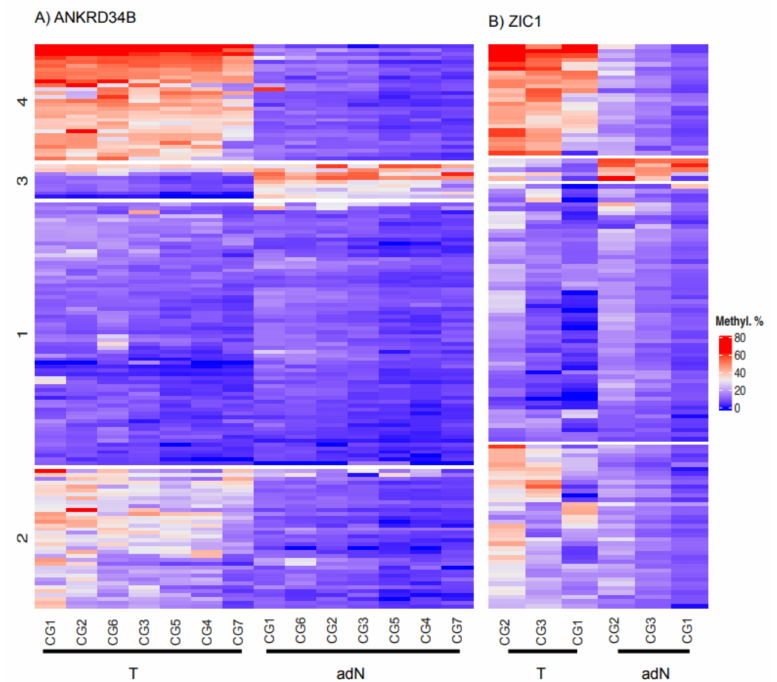
Figure 5. Heatmap presentation of kmeans clustering of CpG site specific methylation in paired tumor adjacent normal and tumoral tissues for independent clustering’s of ANKRD34B ( A ) and ZIC1 ( B ) measured tissues. Relative methylation values were color coded as indicated (Methyl. %) and numbers refer to the designated clusters. Indicated clusters represent consensus clusters after 100 runs using